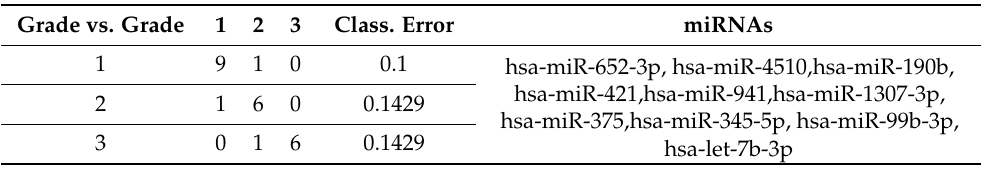
Table 2. Confusion matrix of the 10 most discriminative miRNAs. Classification error indicates the maximum likelihood of making an error in the case of a particular grade.